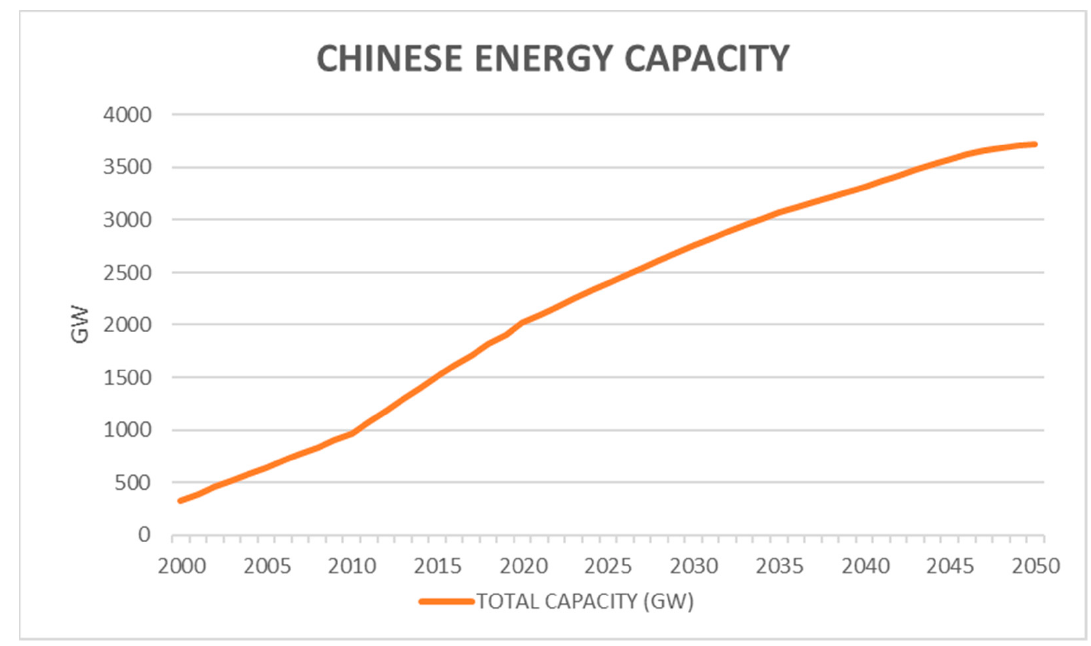
Figure 4. GDP and electricity production from 1971 to 2050 (historical data and forecast) in China.